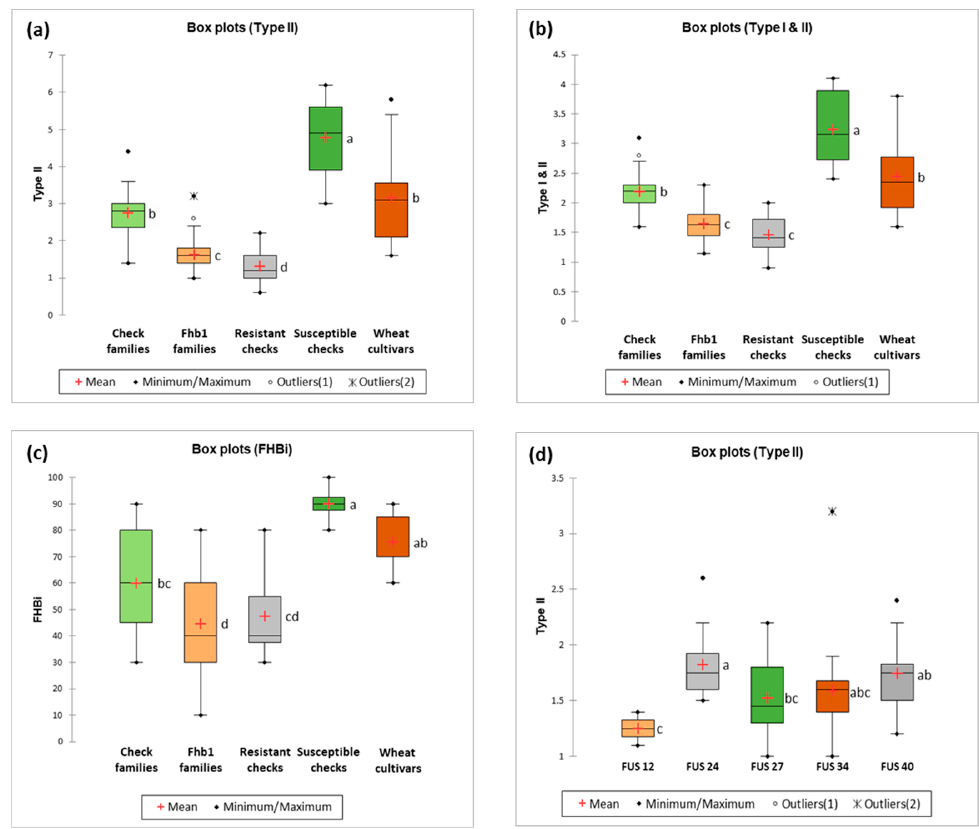
Figure 1. ( a ) Box plot of type II resistance to Fusarium head blight of wheat groups (years 2019 and 2020); boxes marked with the same letter are not significantly different at p < 0.05 according to Tukey’s HSD test performed on log10 transformed data. ( b ) Box plot of mixed type I & II resistance to Fusarium head blight of wheat groups (years 2019 and 2020); boxes marked with the same letter are not significantly different at p < 0.05 according to Tukey’s HSD test performed on log10 transformed data. ( c ) Box plot of Fusarium head blight index of wheat groups; boxes marked with the same letter are not significantly different at p < 0.05 according to Tukey’s HSD test performed on Box–Cox transformed data. ( d ) Box plot of type II resistance to Fusarium head blight of families of five wheat combinations (years 2019 and 2020); boxes marked with the same letter are not significantly different at p < 0.05 according to Tukey’s HSD test performed on log10 transformed